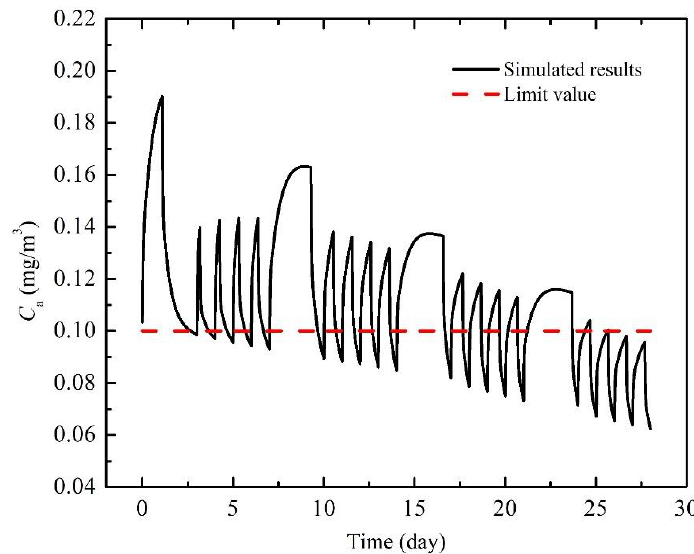
Figure 8. Formaldehyde concentration variations under intermittent ventilation.